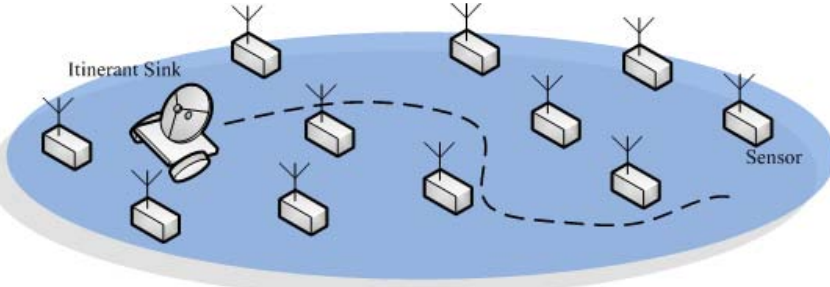
Figure 1. In a UWSN, the itinerant sink roams around the sensing region and collects the data sensed by